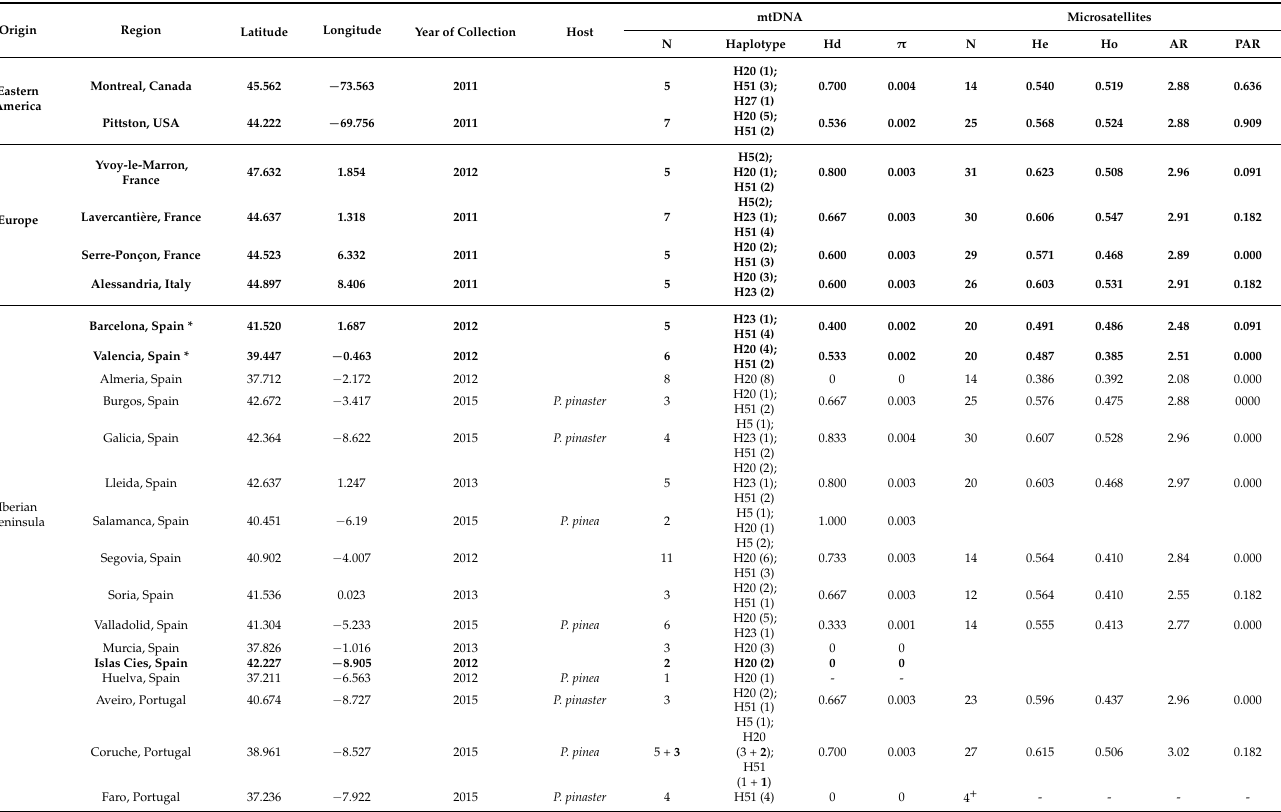
Table 1. Sampling information and genetic diversity (mtDNA and microsatellite markers) of native and invasive populations of the Western conifer seed bug, Leptoglossus occidentalis , based on the current study and Lesieur et al.